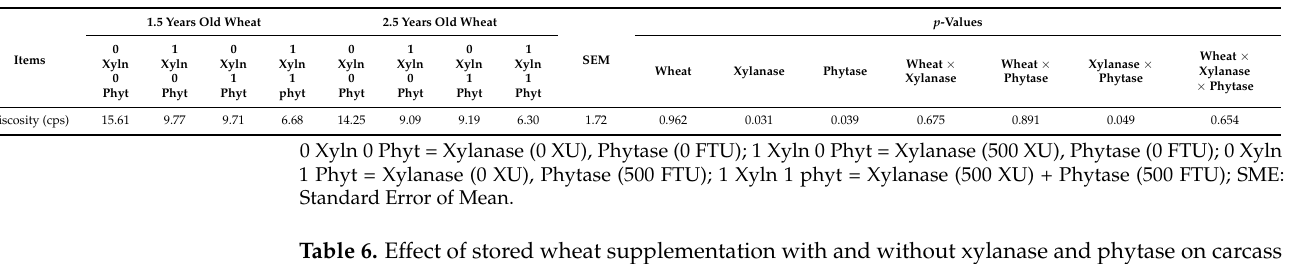
Table 5. Effect of stored wheat supplementation with and without xylanase and phytase on digesta viscosity of broiler birds at day 35.